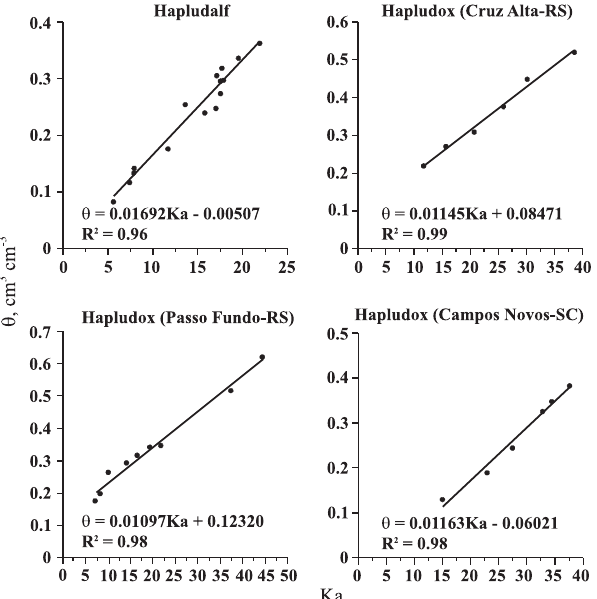
Figure 5. Linear model adjusted between the dielectric constant obtained with the TDR and the volumetric soil moisture.